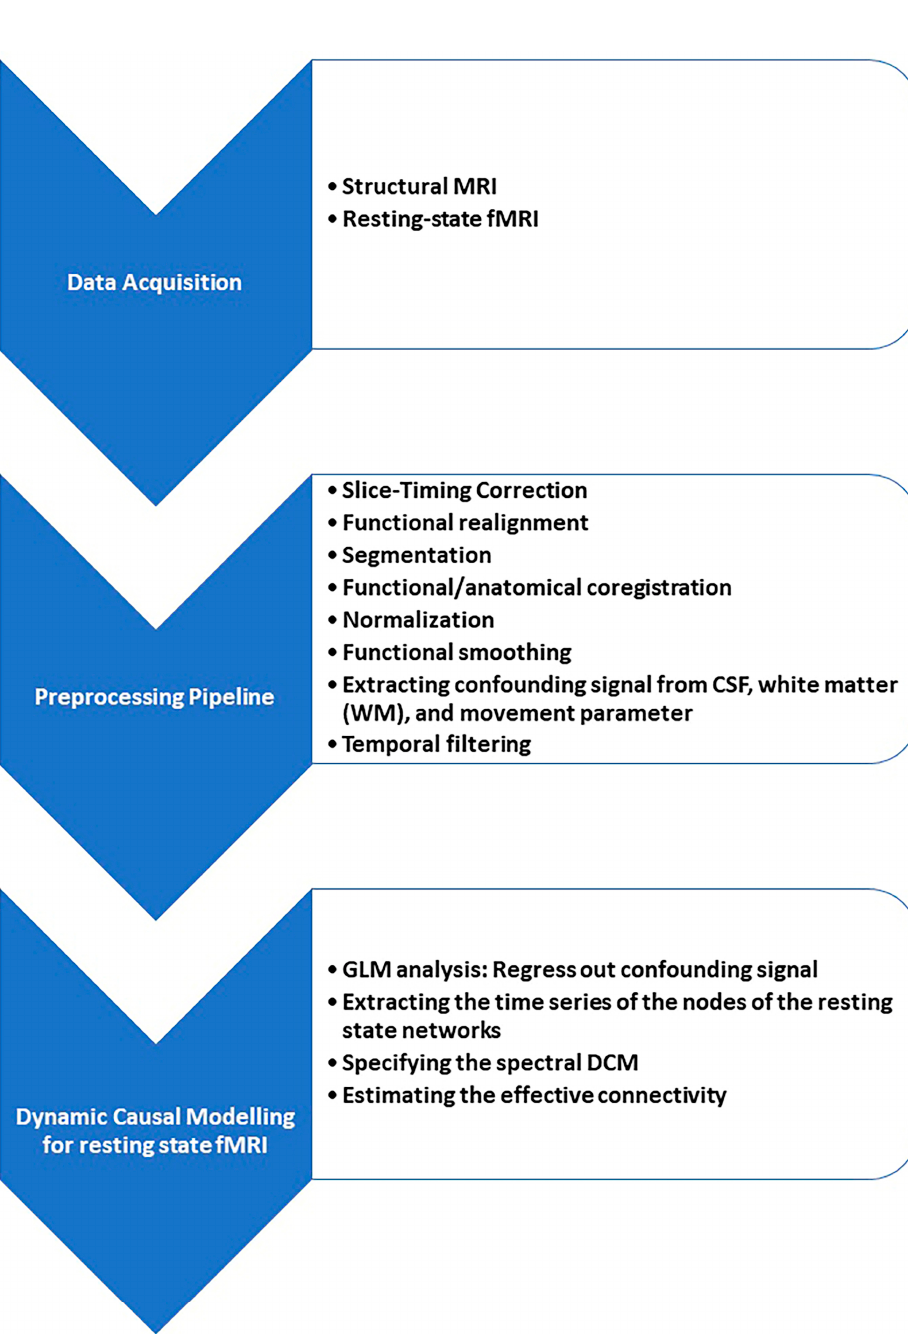
Figure 1. Processing the MRI/fMRI, specifying Dynamic Causal Modeling (DCM), and estimating the effective connectivity.